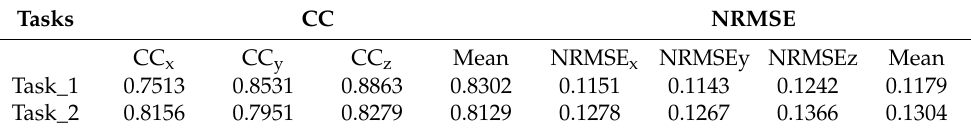
Table 2. The performance of intention prediction for slow movement in 3-D (x, y, and z axes). Tasks